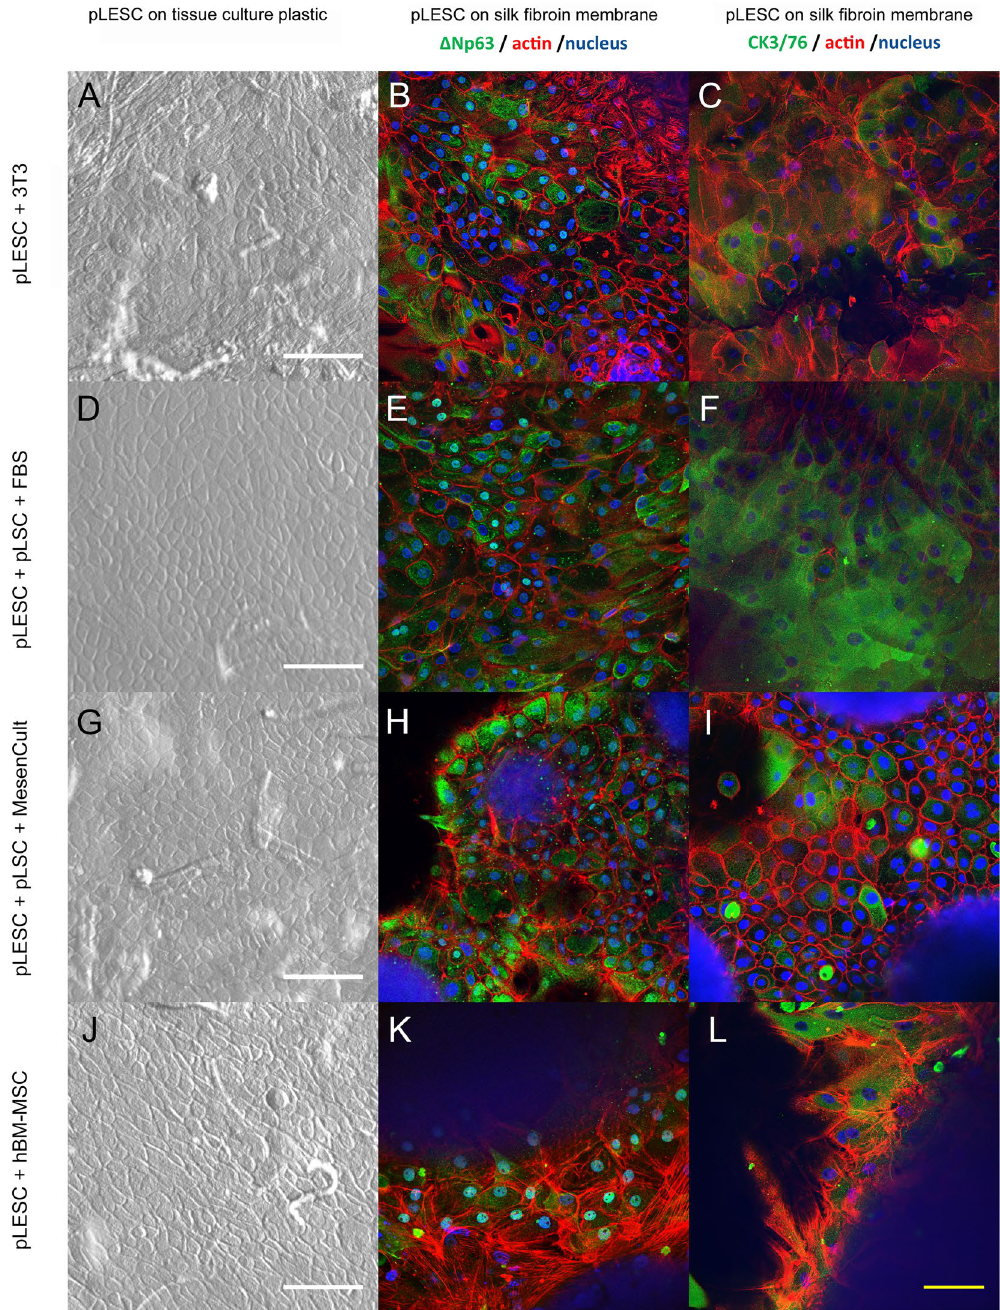
Figure 7. Capacity of pLSCs, hBM-MSCs and 3T3s to support pLESC growth. PLESCs were cultured on silk fibroin membranes with growth-arrested murine 3T3 fibroblasts ( A–C ), pLSCs grown in serum-containing ( D–F ) or serum-free media ( G–I ), and hBM-MSCs ( J–L ). Typical cobblestone morphology could be seen under the bright field microscope (left column). Δ Np63-positive cells (center column) and cytokeratin (CK) 3/76 positive staining (right column) were visible. White scale bar = 200 μ m, yellow scale bar = 300 μ